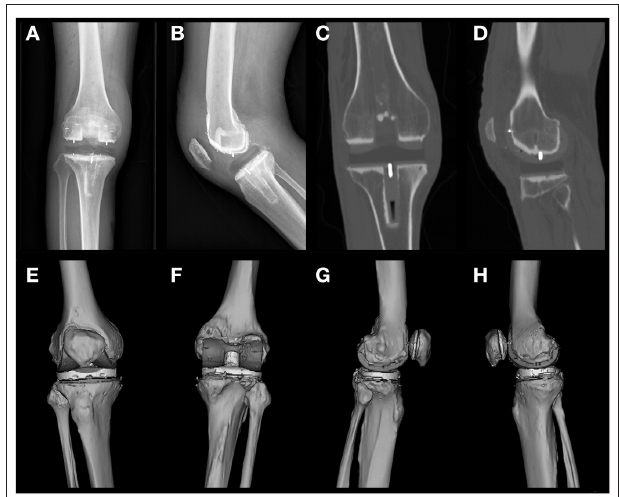
FIGURE 2 | Postoperative X-rays of frontal and lateral views of patient 1 (A,B) , images of postoperative CT coronal intermediate and lateral condyle central layers (C,D) , and a preview of the 3D reconstructed model (E–H) are shown. CT level selection: coronal, sagittal, and axial positions consistent with the joint force lines. The most central metal line was selected according to the position of the central tibial plateau prosthesis and the central lateral femoral condyle. The most central position of the metal wire was selected as the intercept plane (C) . Mimics reconstruction software was used to arrange the viewing angles in the order of anterior, posterior, lateral, and medial positions (E–H)